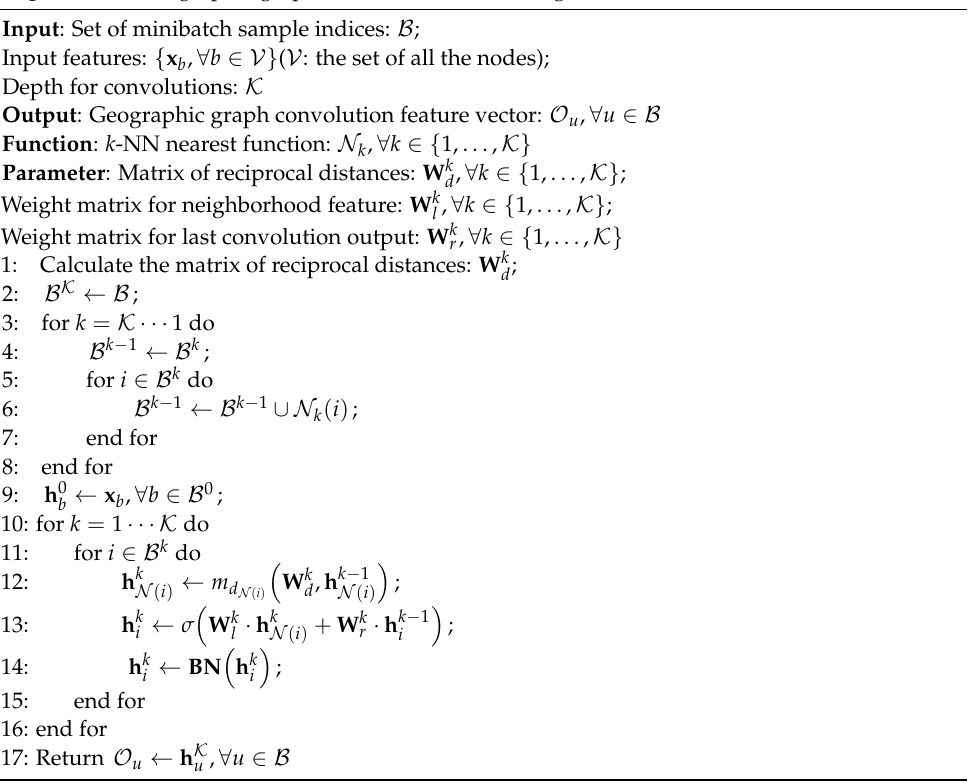
Algorithm 1 : Geographic graph convolution forward